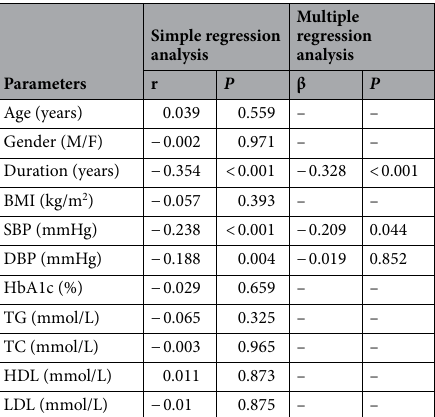
Table 5. The correlation between aqueous humor myonectin concentrations and various parameters. Abbreviation as Table 1. The correlation between aqueous humor myonectin and other parameters were analyzed using simple linear regression analysis. Then the variables with a P < 0.05 were entered into a multiple linear regression model to determine the contribution of various factors to aqueous humor myonectin.